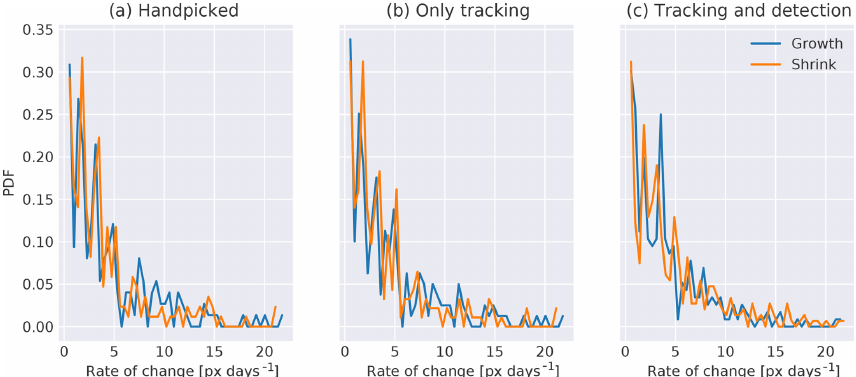
Figure 10. Probability distribution function for growth rates in (a) the handpicked reference data, (b) the automatically tracked features of the handpicked features, and (c) the automatically tracked features of the automatically detected features separated into growth for positive growth rates and shrink for negative